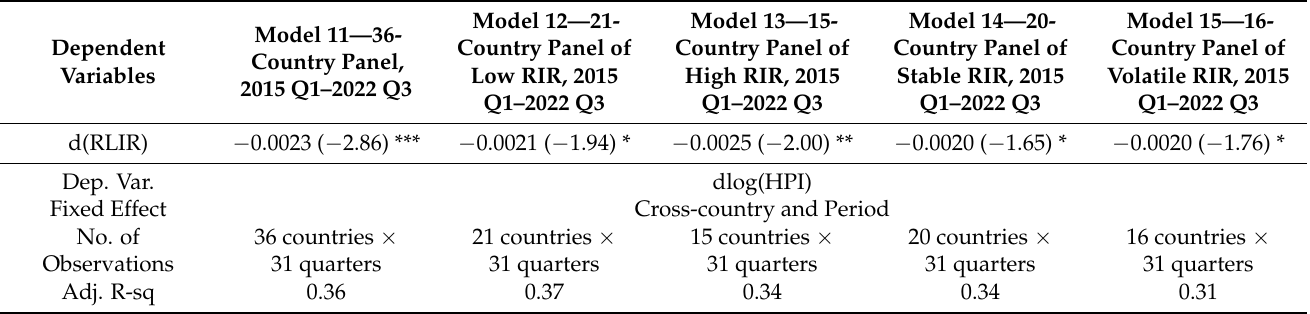
Table 7. Robustness tests results of the 36-country panel regression models on house price change and real long-term interest rates, and sensitivity